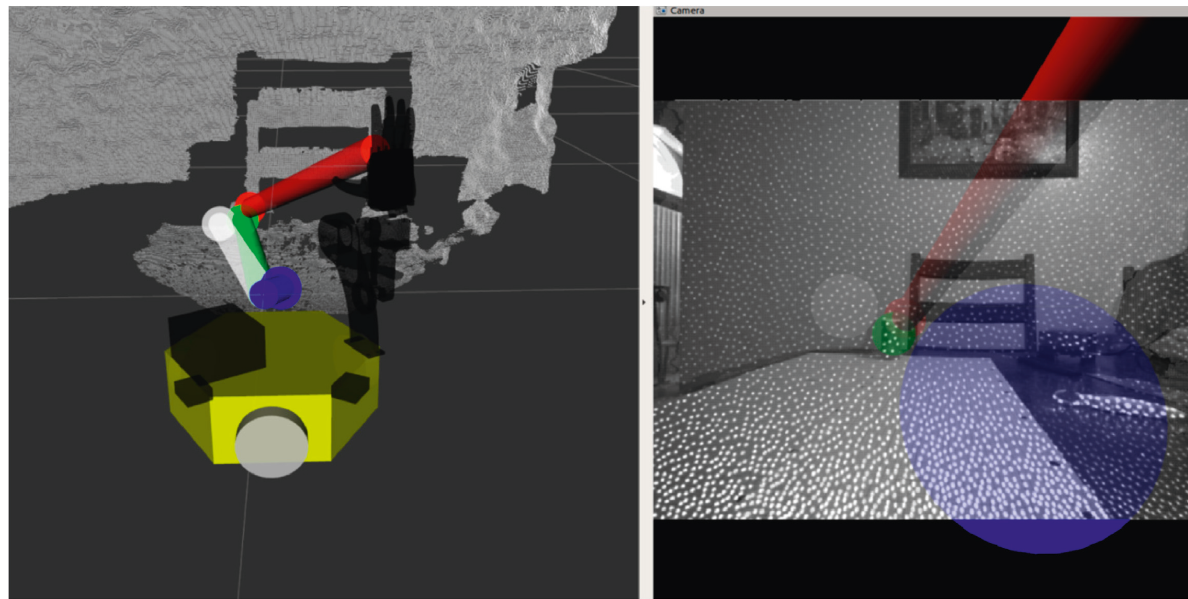
Figure 23: Visualization environment for point verification.